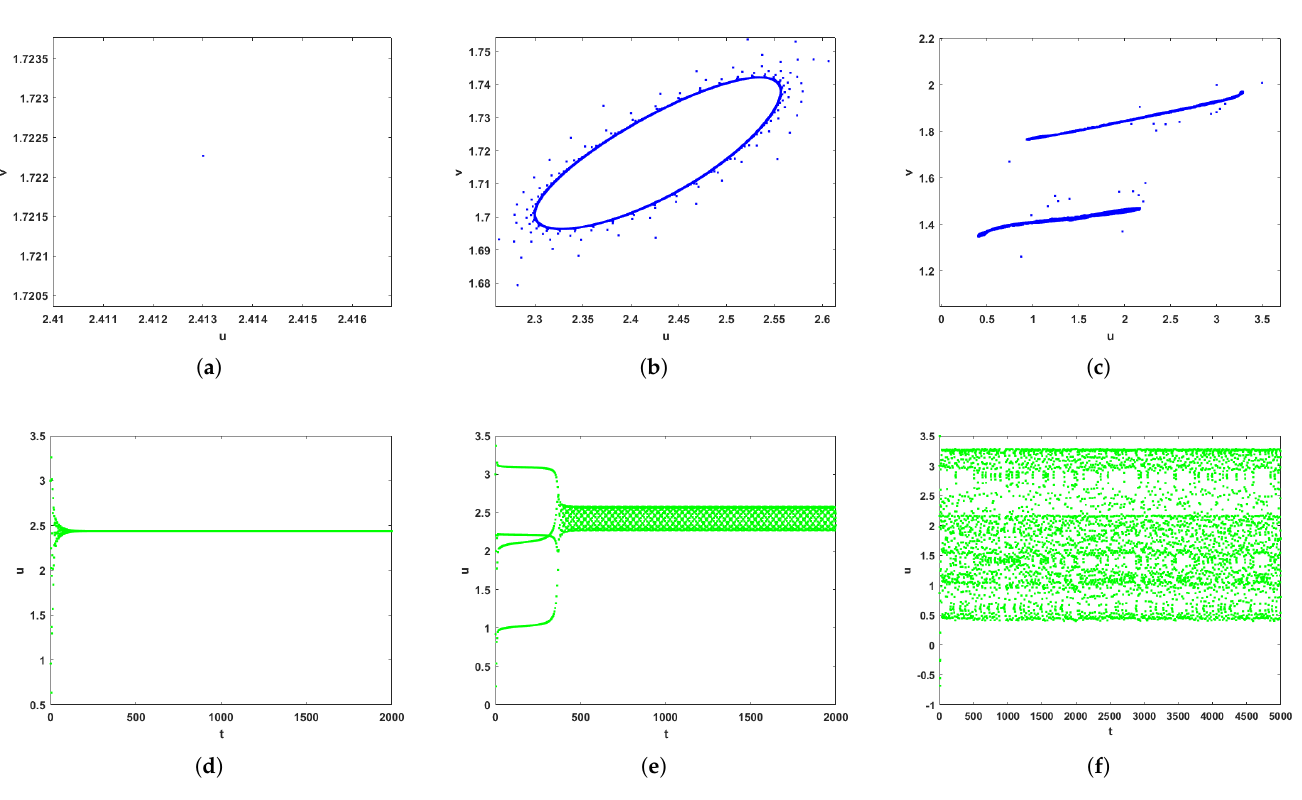
Figure 6. Phase portraits and solution portraits for various values of δ corresponding to Figure 5a. ( a ) δ = 6.8. ( b ) δ = 6.94. ( c ) δ = 7.1. ( d ) solution portrait for δ = 6.8. ( e ) solution portrait for δ = 6.94. ( f ) solution portrait for δ = 7.1.